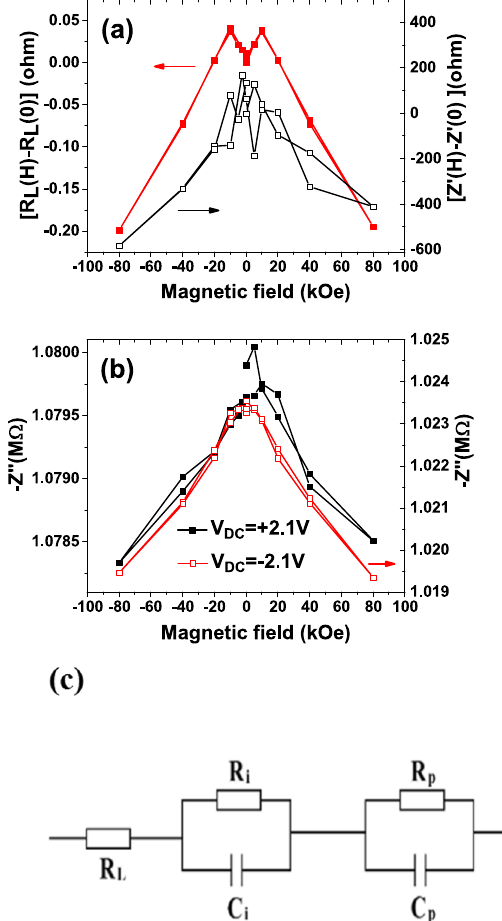
Figure 4. ( a ) Experimental DC magnetoresistance measured for a 20 nm thick epitaxial LSMO layer deposited on (100)-oriented STO using the same parameters as for the heterostructure (red full squares) and Z t ′ (H) − Z t ′ (0) for the LSMO-PZT-LSMO heterostructure for V DC = + 2.1 V; ( b ) Magnetic field dependence of imaginary part of the impedance Z ″ at large applied DC voltages; ( c ) The equivalent circuit used for the simulation of the experimental